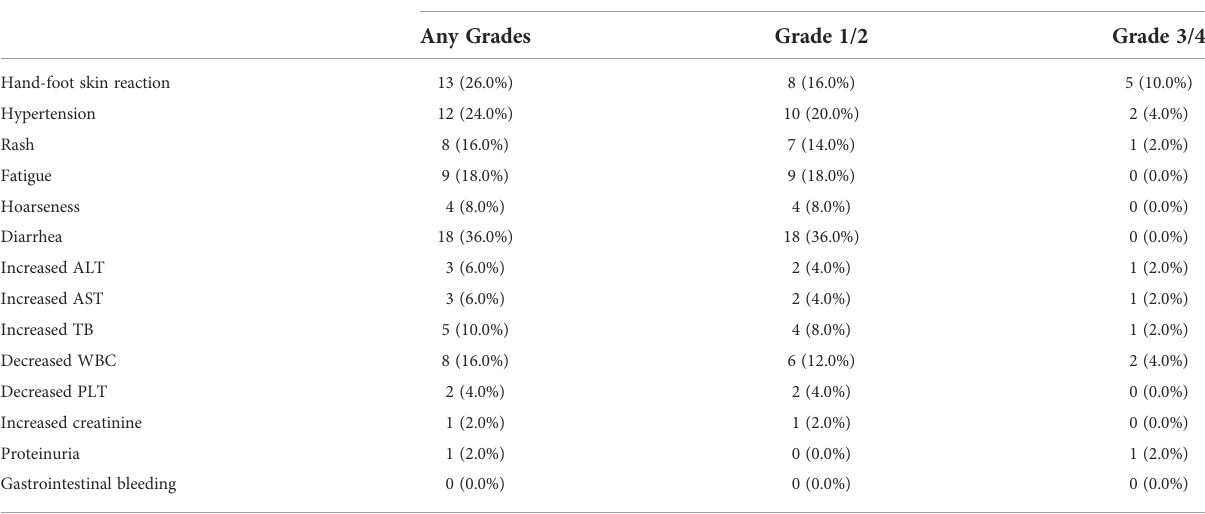
TABLE 6 TRAEs of lenvatinib as second-line treatment in patients with unresectable HCC.